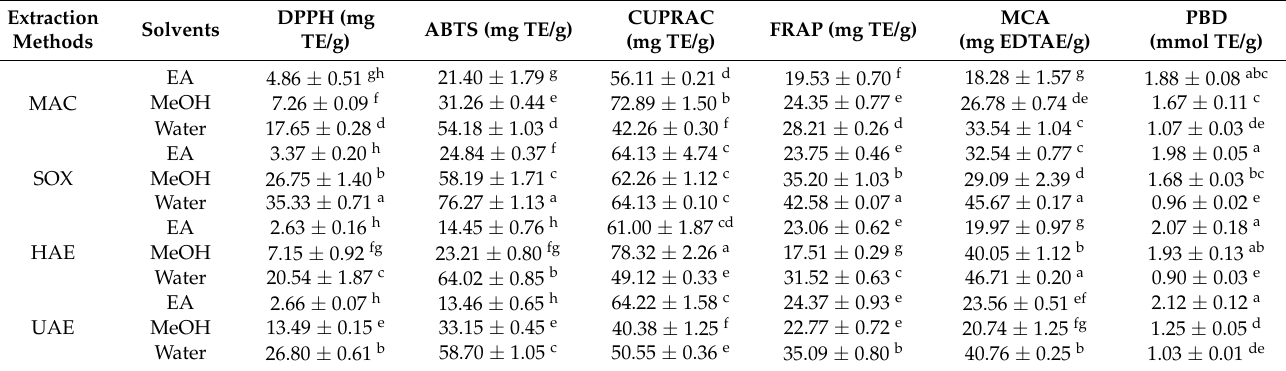
Table 3. Free radical scavenging abilities, reducing power, metal chelating and total antioxidant (by phosphomolybdenum assay) abilities of the tested